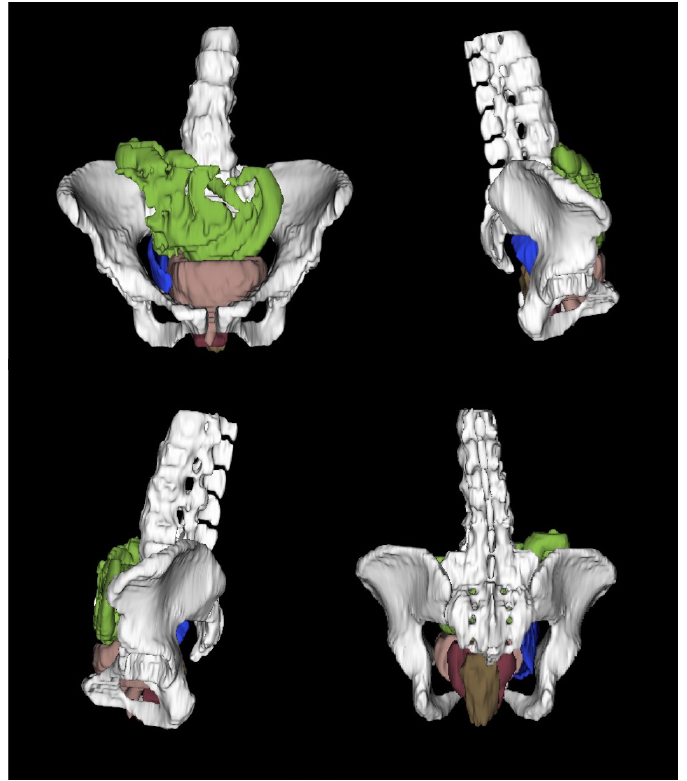
Figure 2. 3D models of the pelvic floor with abdominal structures. The lumbar spine with sacrum, pelvic bones, bladder, vagina, rectum, pressure array, and bowel were segmented. Each segment was loaded into a scene to create a three- dimensional model of the cadaver in the supine position. The X-ray images were utilized to model the cadaver’s pelvic floor in the sitting and standing positions. Each segment was aligned to the X-ray images via the transform module. A linear transform was created for each segment in each position to correctly orient the model with the X-ray images. The left column of Figure 1 shows the original radiologic data